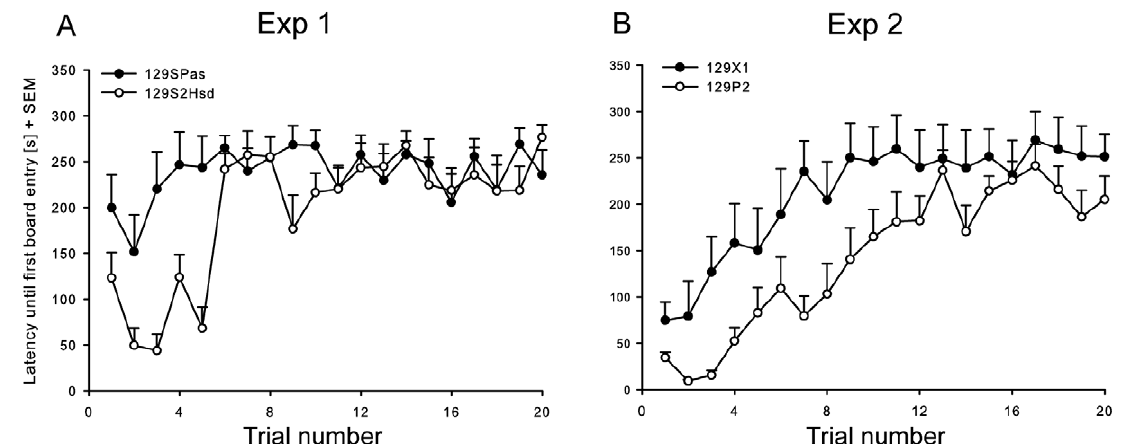
Figure 1. Mean latency from the start of the trial until the first board entry (seconds + SEM). (1A) Experiment 1: 129SPas and 129S2Hsd mice, (1B) experiment 2: 129P2 and 129X1 mice.